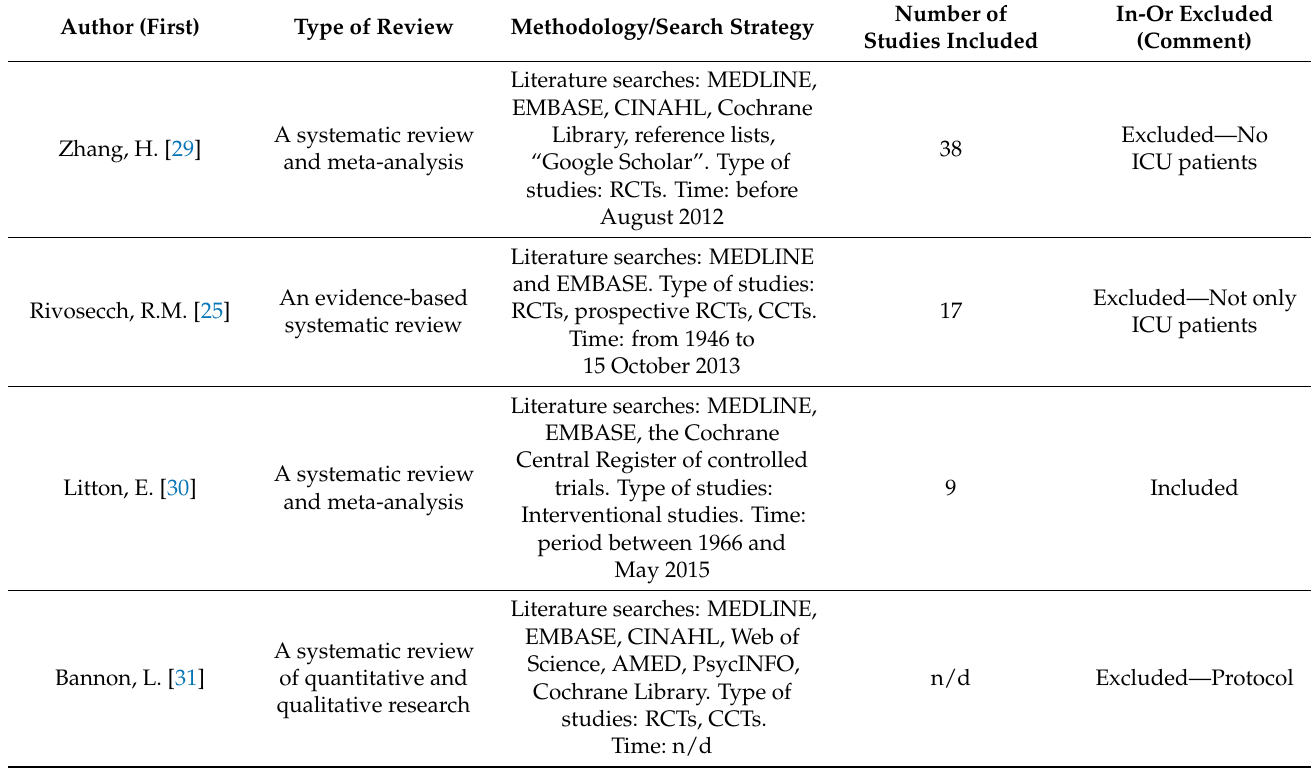
Table 2. Results of data